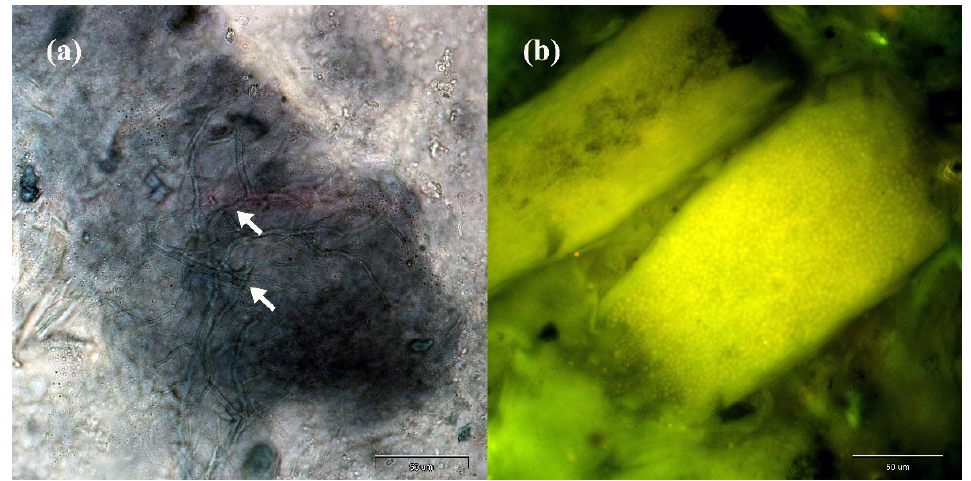
Figure 1. Direct preparation from human skin scrapings and hairs stained with chlorazol black E ( a ) and calcofluor white ( b ) magnified 400× (Olympus BX51, Tokyo, Japan): ( a ) mycelium fragments indicated by arrows; ( b ) arthrospores indicated by green fluorescence.